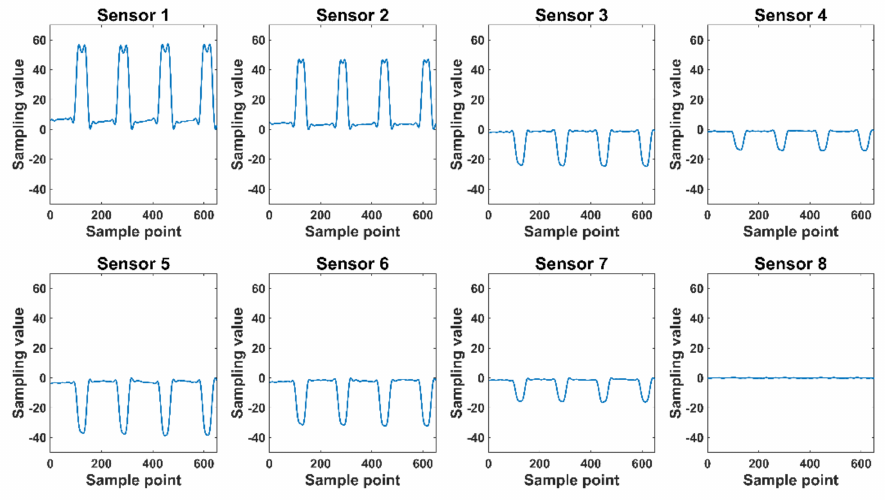
Figure 6. The signals of Sensor